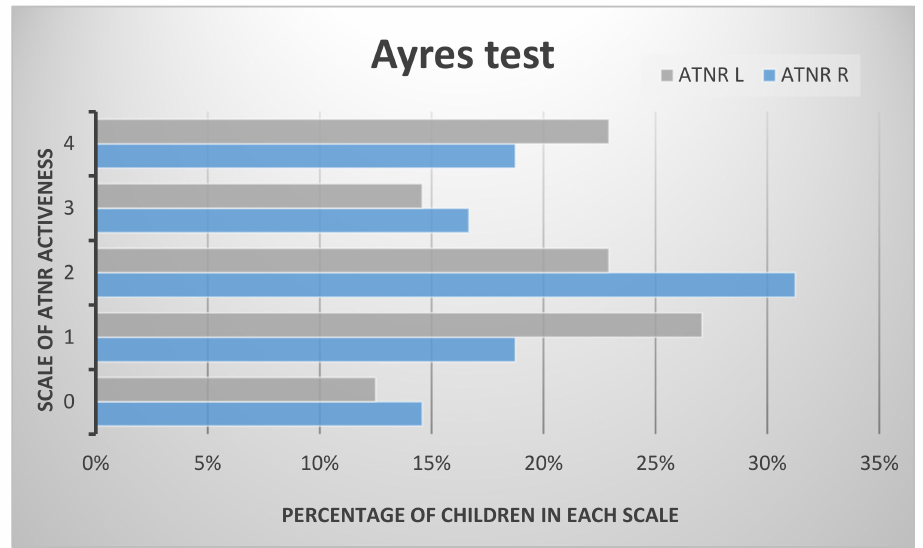
Figure 1. The results of asymmetrical tonic neck reflex (ATNR) in the examined group in the Ayres